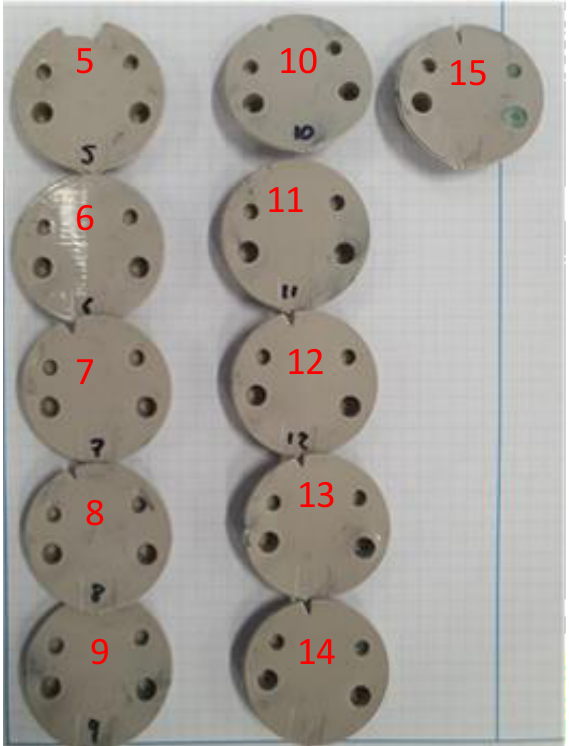
Figure 25. Part sequence, moulded using 20 s cooling time. Numbers refer to shot. Parts 1–4 not shown as they are were not fully formed due to shorter cooling time. Mould failure occurred at shot